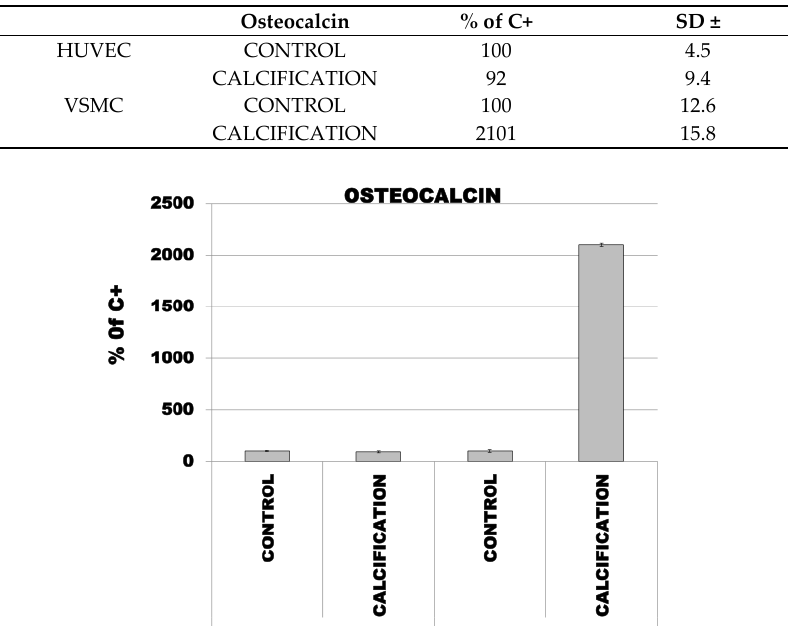
Figure 3. Expression of OP, OPN and RUNX2 in control and calcified HUVEC and VSMC.